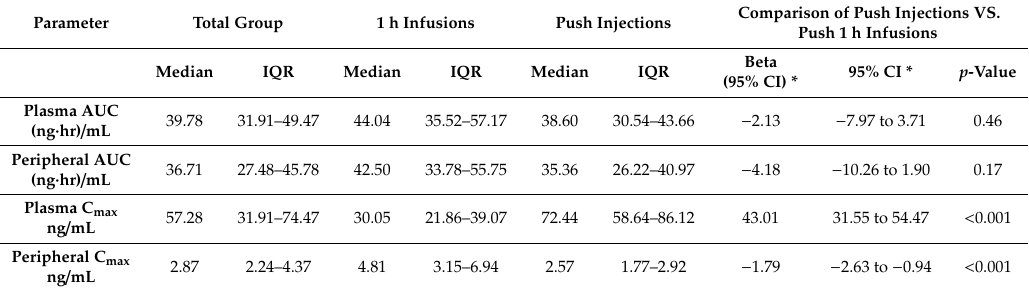
Figure 2. Individual weighted residuals for the final model. Black Squares: 1 h infusion data; black stars: push data. Table 3. Post-hoc pharmacokinetics of vincristine per the administration method, additionally corrected for age, sex, vincristine (VCR) dose per m 2 , disease, concurrent azole antifungal treatment, and self-declared